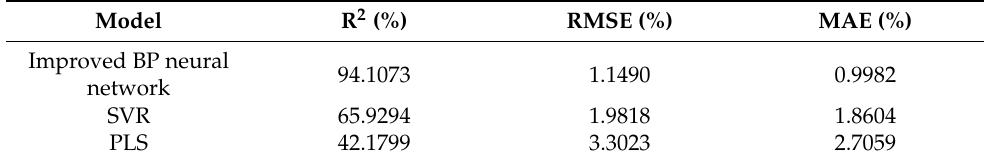
Table 7. Validation metrics for the different